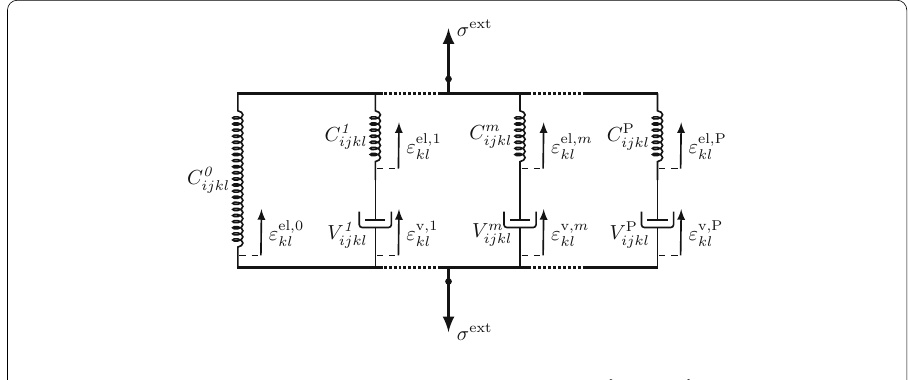
Fig. 1 Maxwell-Wiechert model: A rheological representation with m = branches, where σ ext is an outer stress load, C ijkl is a stiffness tensor, V ijkl is a viscosity tensor, ε el kl is an elastic strain and ε v kl is a viscous strain. A similar representation may be found in e.g. Haupt